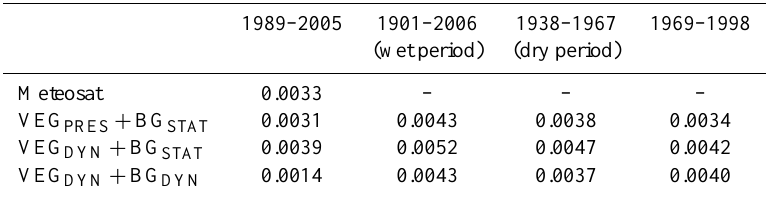
Table 2. Observed and simulated standard deviation of